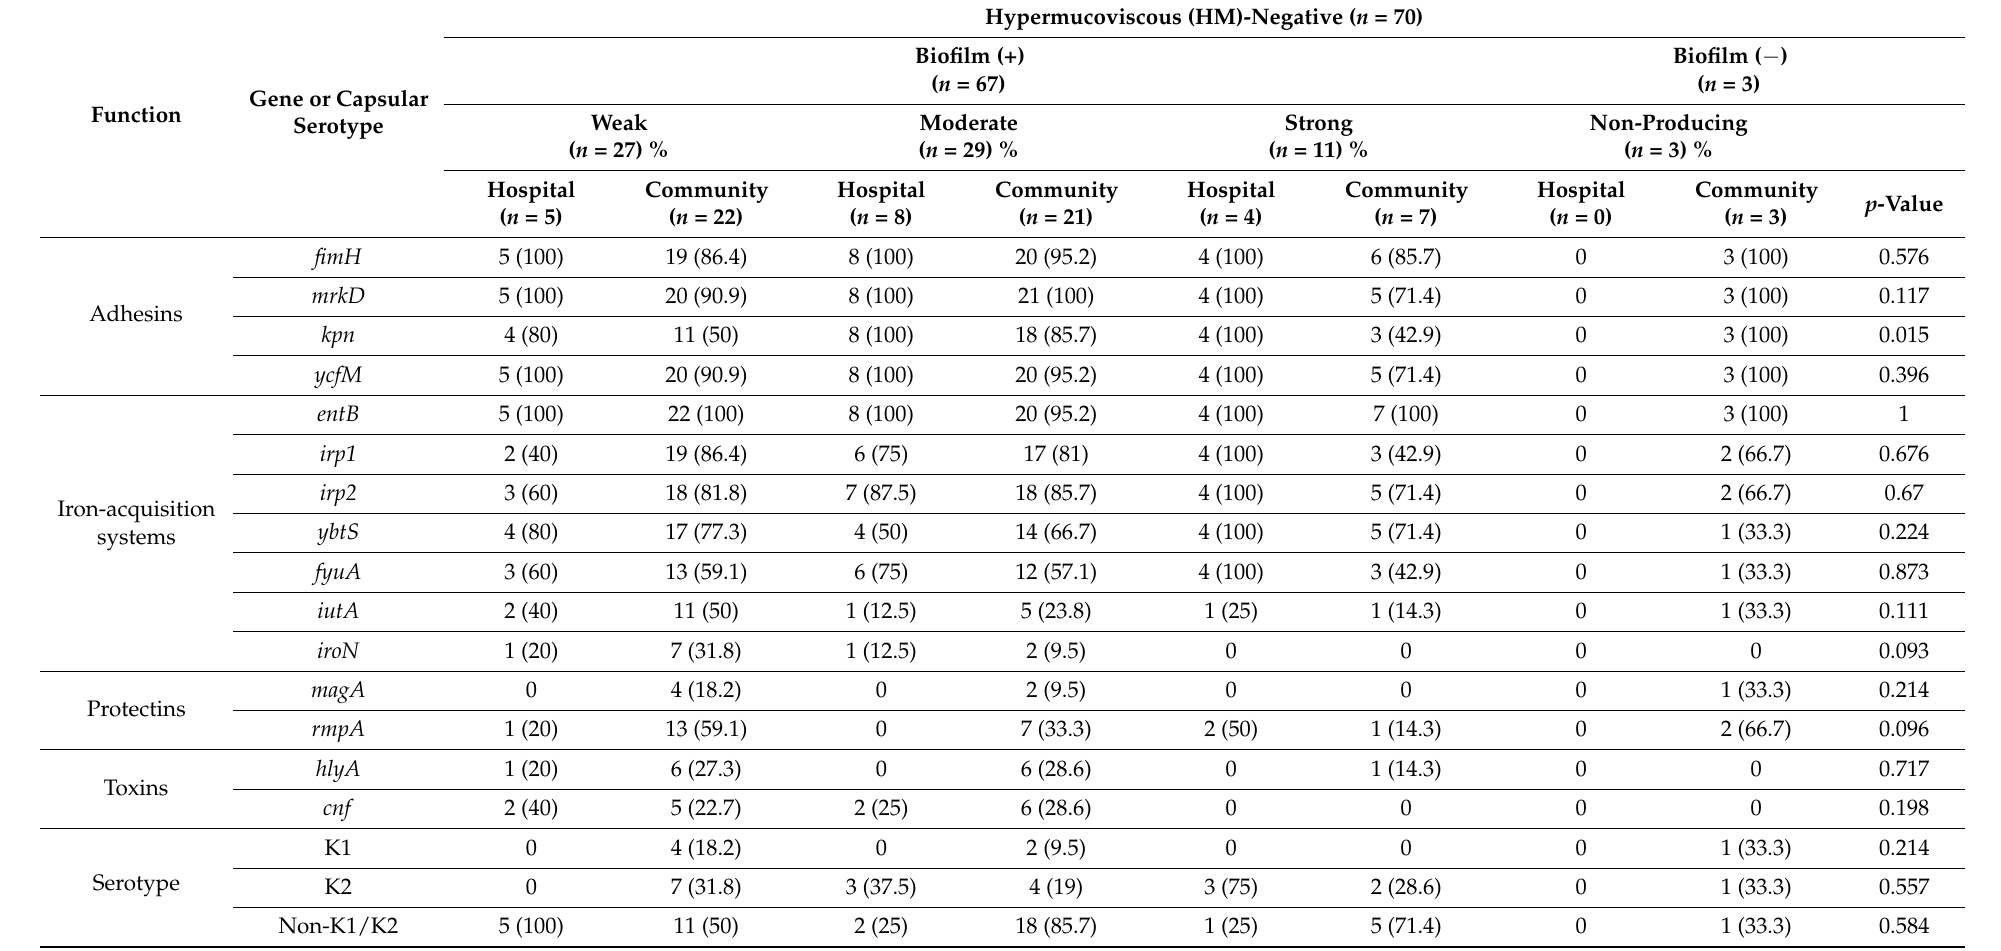
Table 5. Distribution of virulence genes according to hypermucoviscous (HM)-negative strains and biofilm formation of K. pneumoniae isolated from patients with hospital- and community-acquired